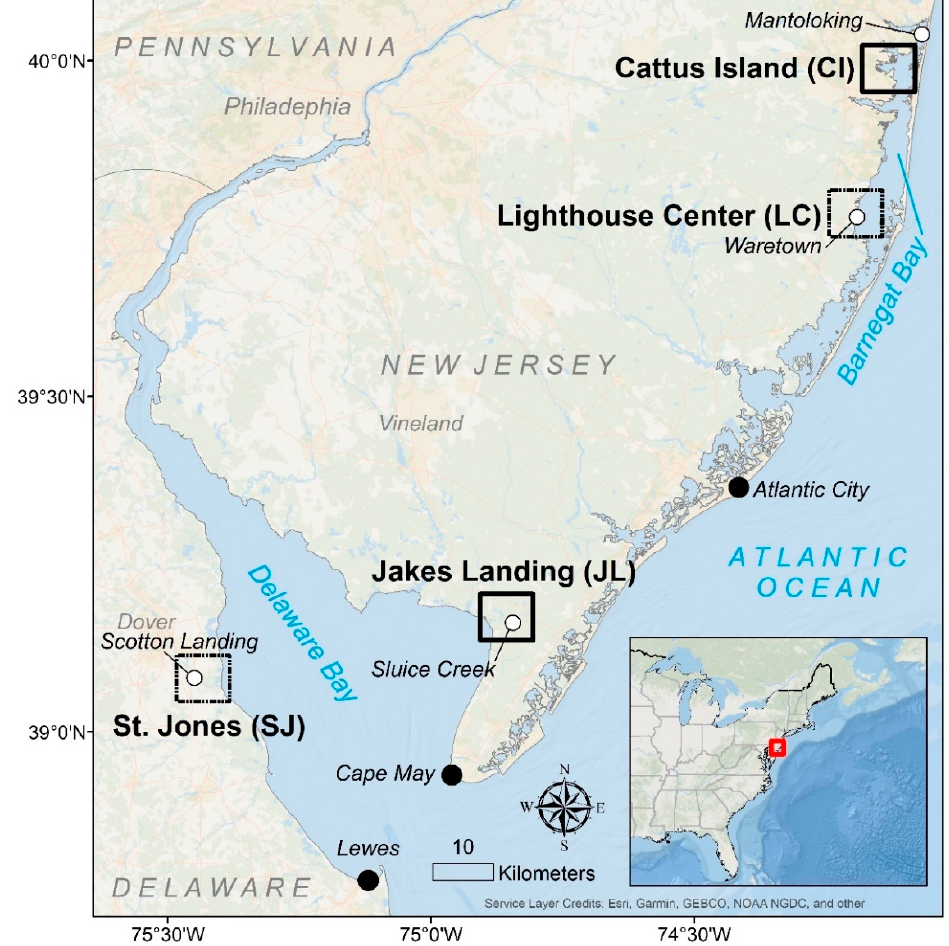
Figure 1. Map of study sites (bold labels), with box colors indicating study tree genera: solid lines are Pinus and broken lines is Ilex. Inset shows position of sites (red box) in the Mid Atlantic, along the eastern coast of the U.S. NOAA tide gauges (black circles) and local gages (white circles) are also depicted in this map. St. Jones and Jakes Landing are in the Delaware Bay, where tides range from 1.6 to 1.8 m. Cattus Island and Lighthouse Center are in Barnegat Bay, a shallow lagoon, where tide ranges are approximately 0.4 m or less.